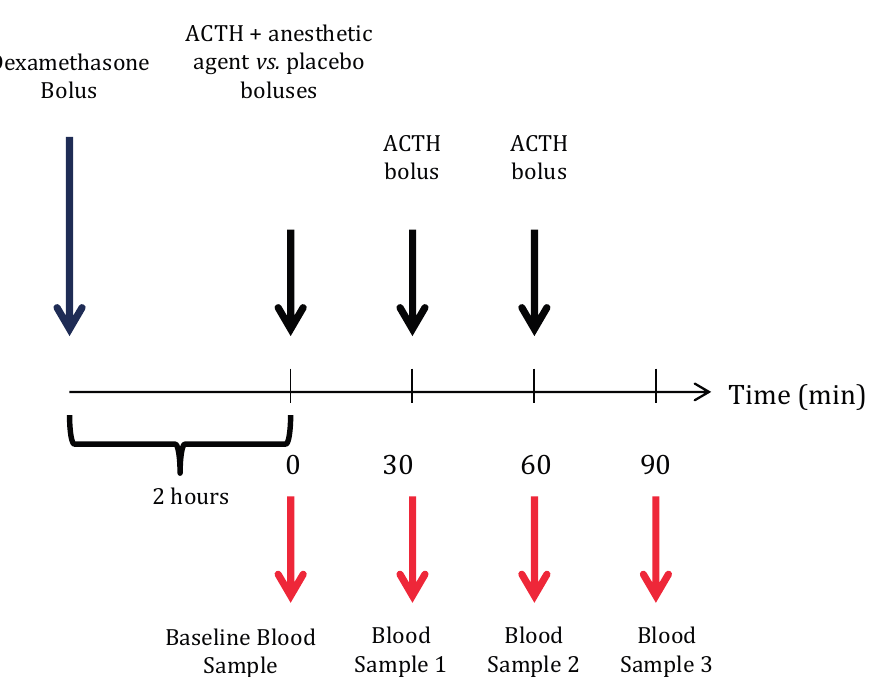
Figure 2. Protocol used to evaluate etomidate’s and ketamine’s residual effects on